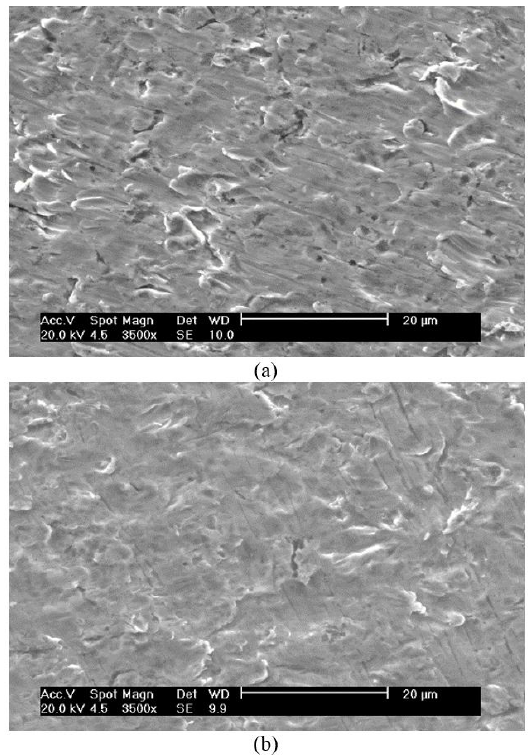
Figure 11. Comparison of surfaces tested with impact angles of (a) 30º and (b) 90 º. steels did not affect significantly the flow corrosion and erosion-corrosion, in the conditions studied in both papers.